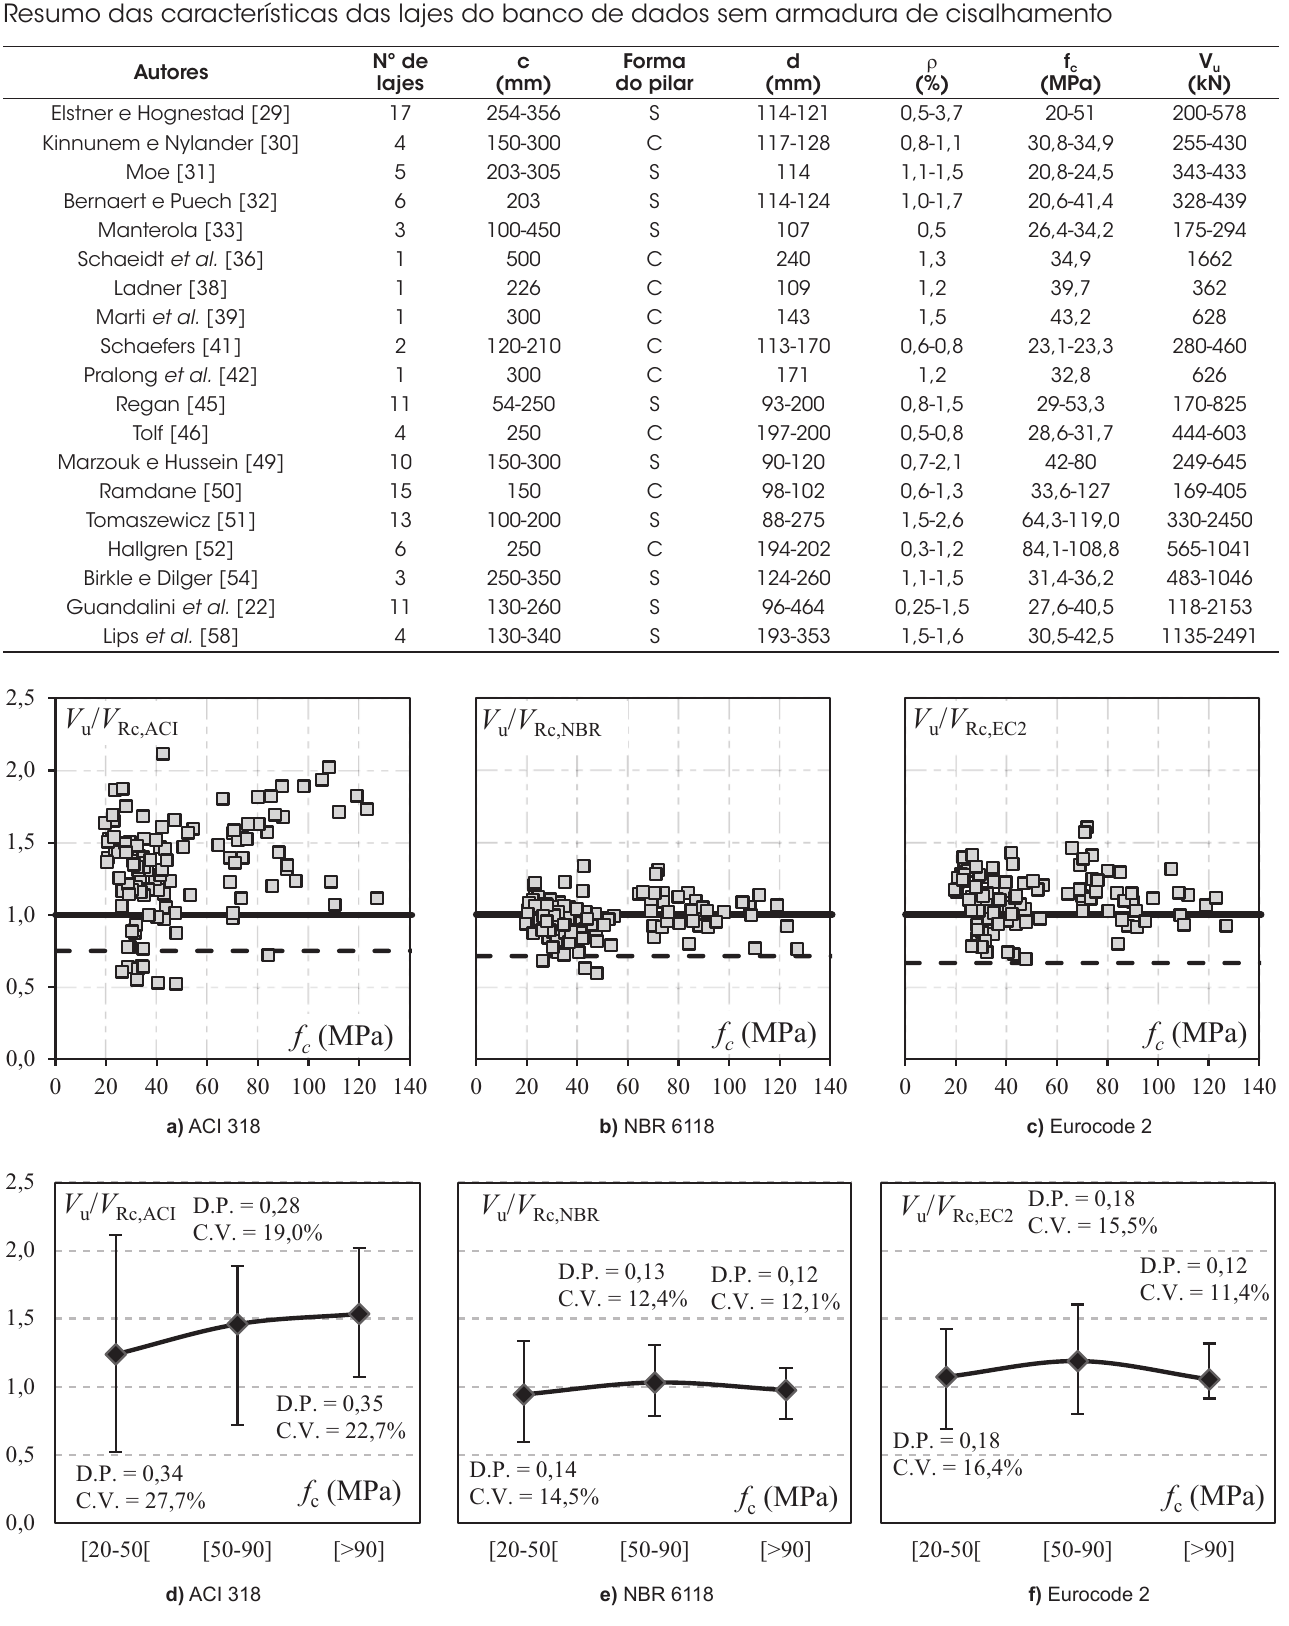
Influência de f no desempenho das normas para lajes sem armadura de c